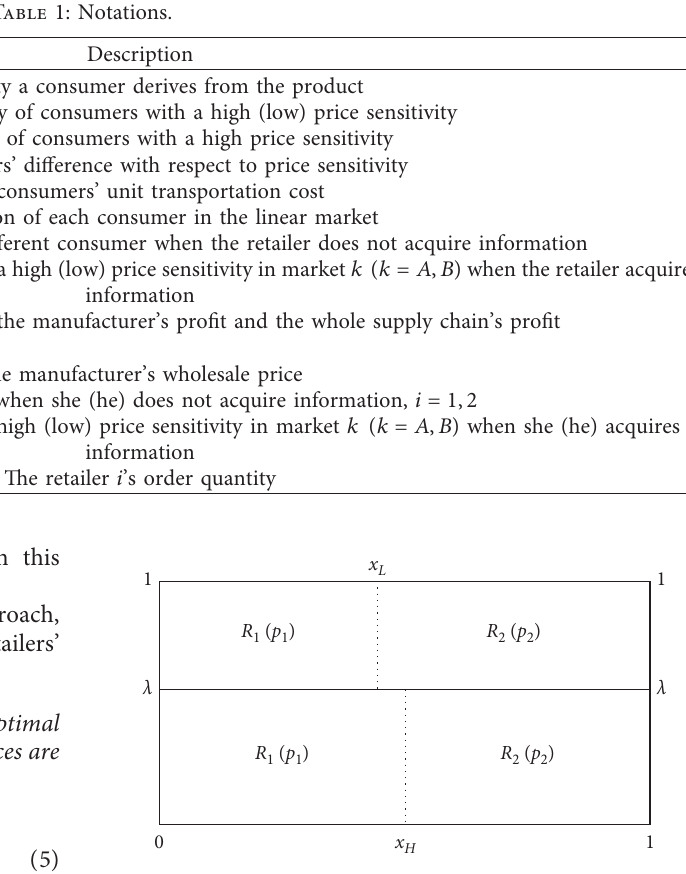
Figure 2: Consumers’ distribution and retailers’ market shares in the NN